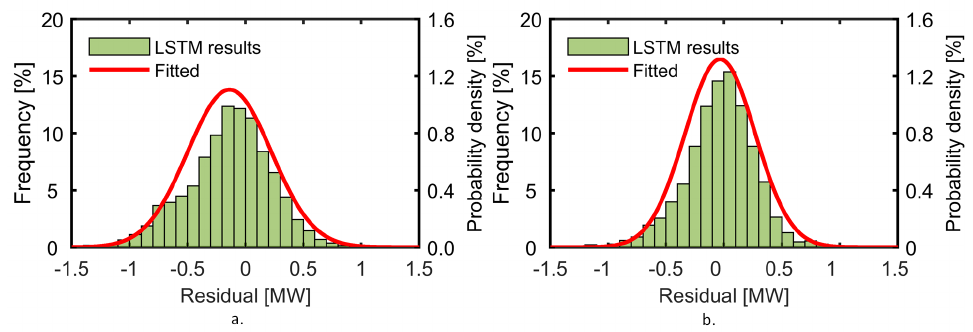
Figure 10. Distribution of errors for the total electric power load forecasts in the summer ( a ) and winter ( b ) with a box size of 100 kW. The mean residual is − 137 kW with a standard deviation of 361 kW in the summer and 33 kW with a standard deviation of 302 kW in the winter, which represent small fractions of the forecasted maximum load of approximately 6